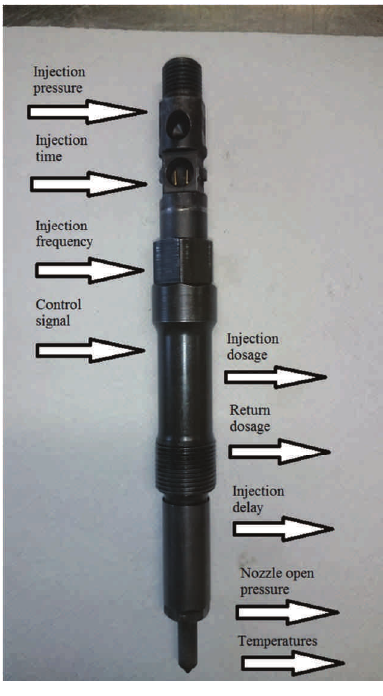
Fig. 3. Fuel injector diagnostic parameters